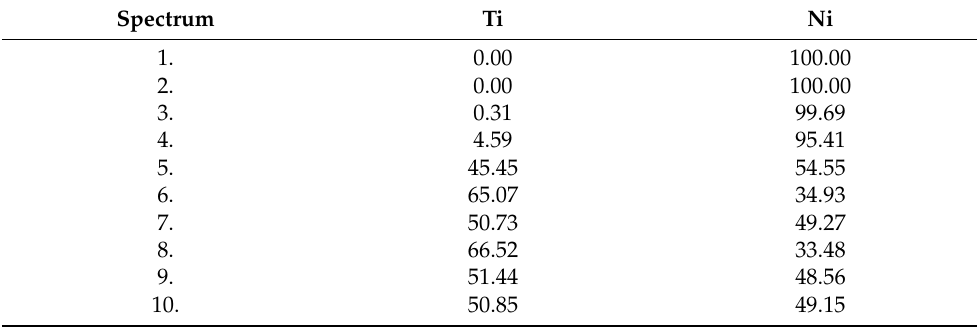
Table 8. EDS point analysis of weld 8 (Ni—weld metal interface) (in at. %). Spectrum Ti Ni 1.